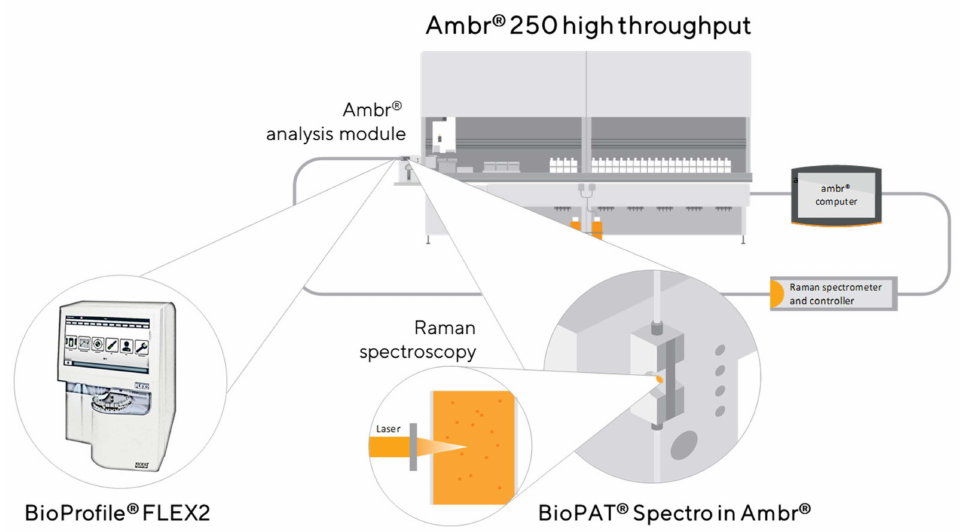
Figure 1. Experimental setup: schematic diagram of the automated 250 mL mini bioreactor system (Ambr ® 250 high throughput, Sartorius, Royston, UK) with a prototype Raman flow cell (path length 1 mm; internal volume ~40 µ L) integrated into the Ambr ® analysis module, enabling automated Raman spectroscopy and an integrated reference measurement system (BioProfile FLEX2, Nova Biomedical Corporation, Waltham, MA,